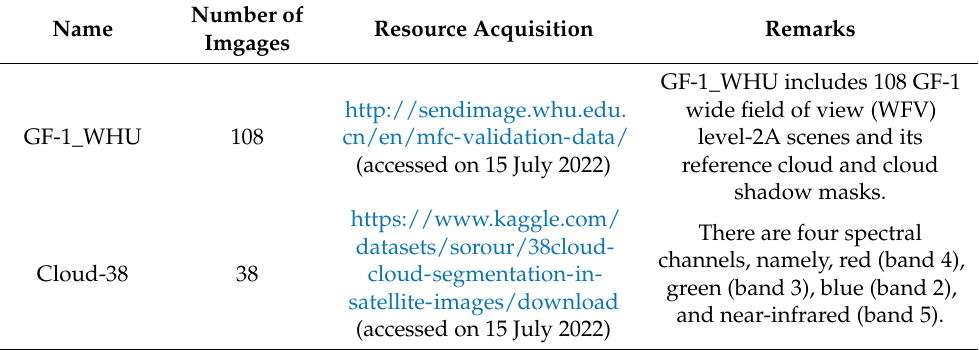
Table 1. Public dataset